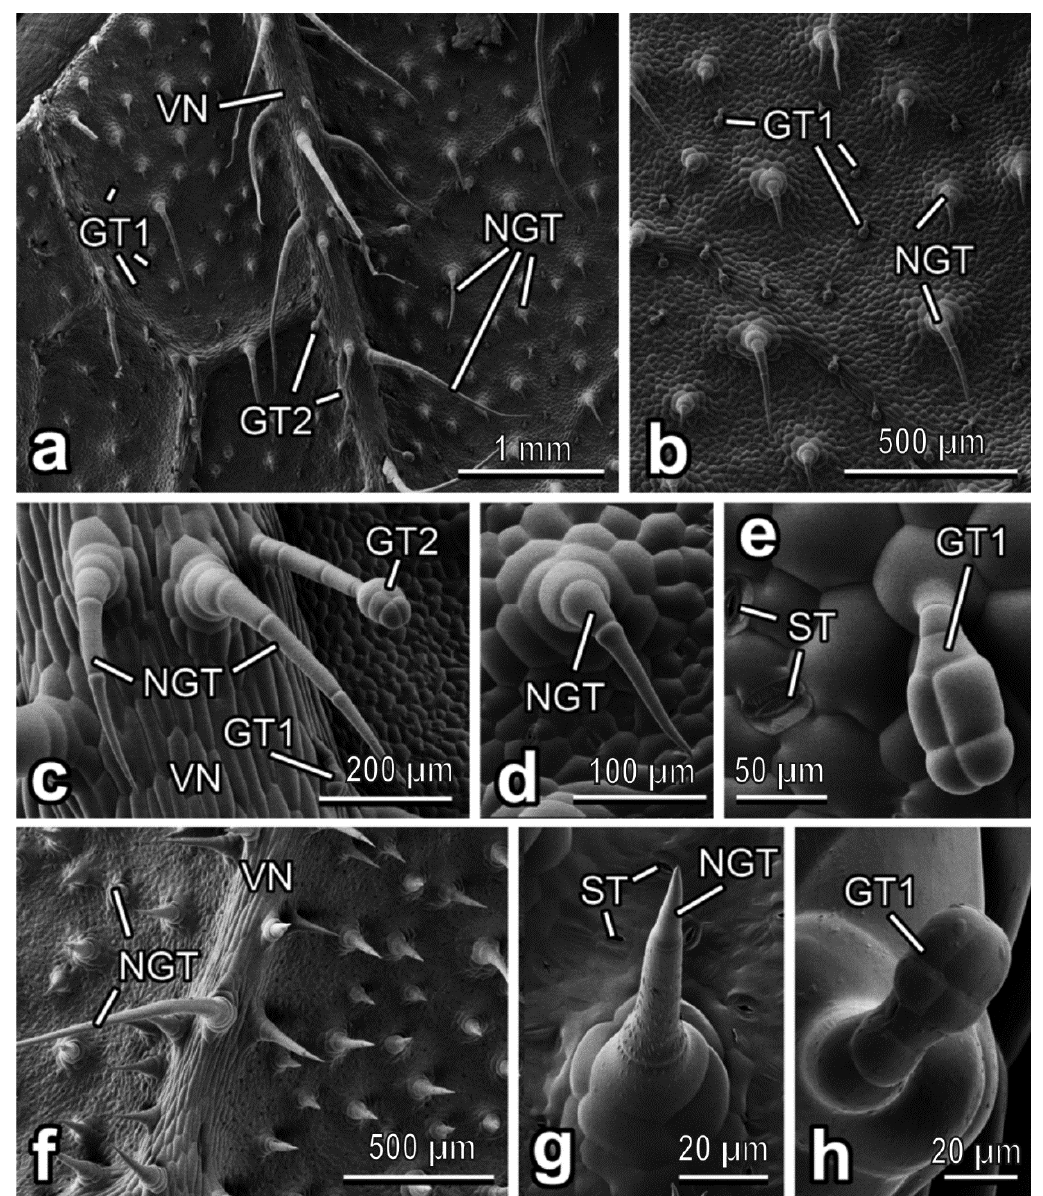
Figure 3. Abaxial leaf side of Citrullus lanatus ( a – e ) and Cucumis melo ( f – h ), cryo-SEM. ( a , f ) Leaf surface with the prominent vein(s). ( b ) Leaf surface between the prominent veins. ( c ) The vein bearing both non-glandular trichomes and a glandular (long-stalked) one. ( d , g ) Non-glandular trichome from the leaf region between the veins. ( e , h ) Glandular (short-stalked) trichome. Abbreviations: GT1: clavate short-stalked glandular trichome; GT2: capitate long-stalked glandular trichome; NGT: non-glandular trichome; ST: stoma; VN: vein.